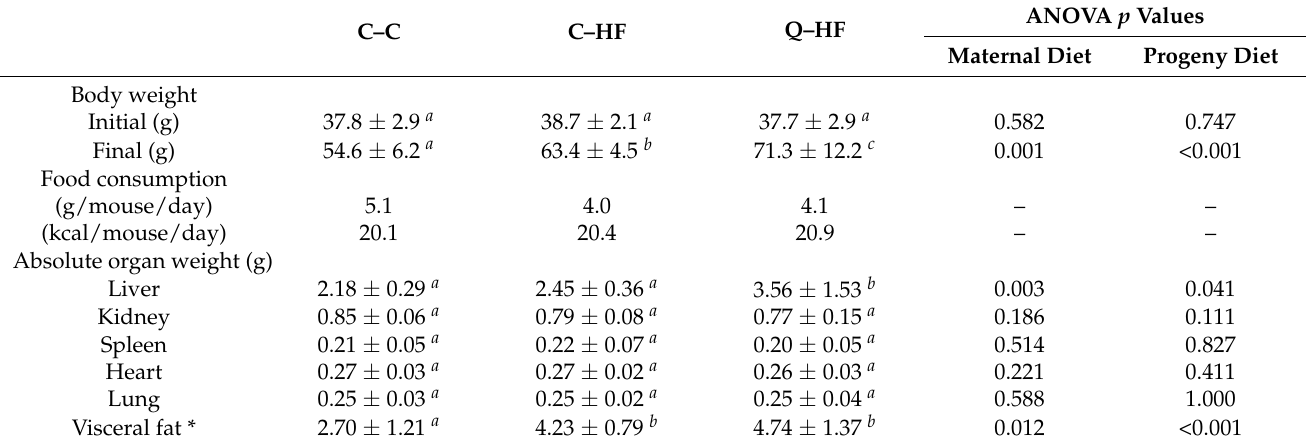
Figure 3. Effects of maternal quercetin consumption on body weight gain in progeny fed a HF diet. Male progeny of dams fed a control diet (C) or a diet containing 1.0% quercetin (Q) were divided into three groups: progeny of dams fed the C-diet that were also fed the C diet (C-C, ), progeny of dams (cid:35) fed the C-diet that were fed a 30% high-fat (HF) diet (C-HF, (cid:3) ), and progeny of dams fed Q-diet that were fed a HF diet (Q-HF, (cid:4) ). The animals were permitted free access to deionized water and the C-diet or HF-diet for 13 weeks. Data are shown as the mean ± SD (n = 10). Two-way ANOVA analysis were performed, and Fisher’s PLSD post hoc test was applied if ANOVA p values were less than 0.05. * vs. the C-C group, # vs. the C-HF group ( p < 0.05). Table 3. Absolute and relative organ